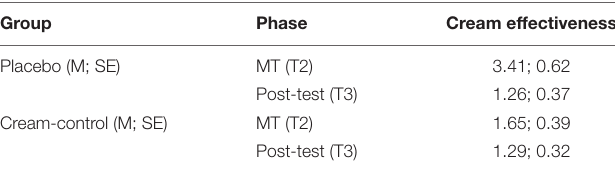
TABLE 3 | Cream effectiveness in the Placebo group (PG) and Cream-control group